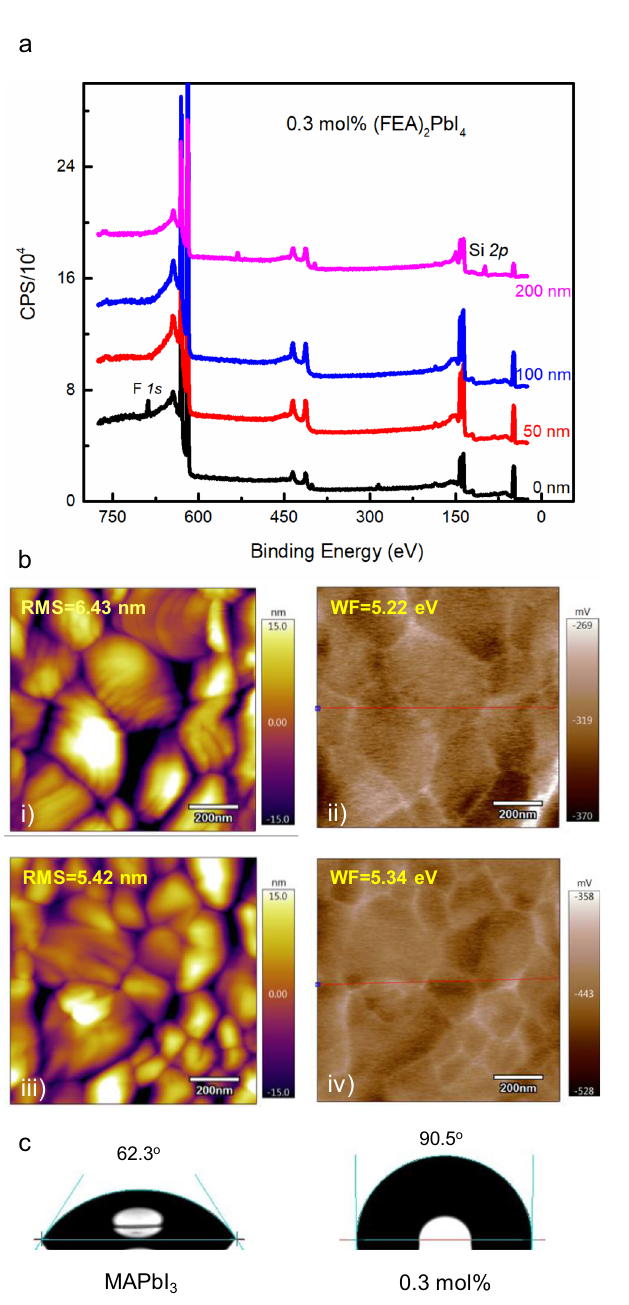
Fig. 5 XPS, AFM, SKPM and water contact angle measurements of the thin fi lms. a XPS depth pro fi le on a 0.3 mol% (FEA) 2 PbI 4 -containing perovskite fi lm (CPS = counts per second). b AFM of the surface of the (i) MAPbI 3 and (iii) 0.3 mol% (FEA) 2 PbI 4 -containing perovskite fi lms and work function images of (ii) MAPbI 3 and (iv) 0.3 mol% (FEA) 2 PbI 4 - containing perovskite fi lms obtained from the SKPM measurements (RMS = root mean square roughness and WF = work function). c Images of water droplet contact angle measurements of MAPbI 3 and 0.3 mol% (FEA) 2 PbI 4 -containing fi lms on glass/ITO/PTAA/PFN-P2 substrates. A higher (FEA) 2 PbI 4 content at the surface of the perovskite fi lm would be expected to lead to an increase of the work function the surface morphologies from atomic force microscopy (AFM)